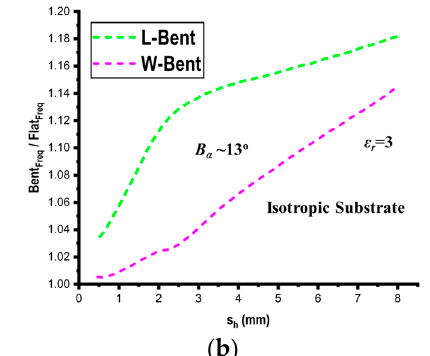
Figure 11. Bending effect on an isotropic substrate with respect to the bending angle ( B α ) ( a ) and substrate height ( s h ) ( b ).